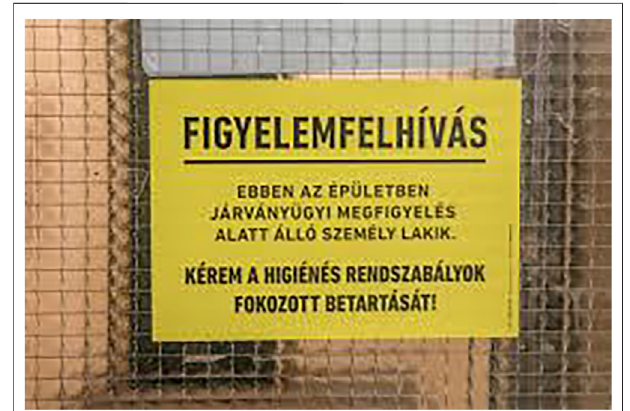
FIGURE 3 | Sticker placed on apartment doors in Hungary. The yellow sticker warns of the presence of a person in the building under surveillance by epidemiologic authorities. Source: ripost.hu.